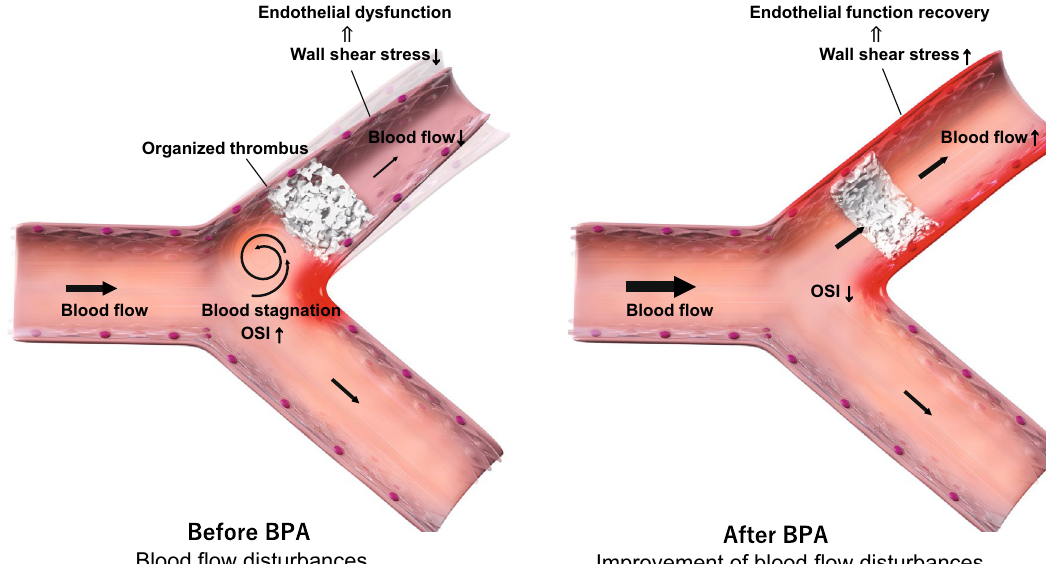
Figure 7. Working hypothesis of pulmonary artery blood flow dynamics before and after